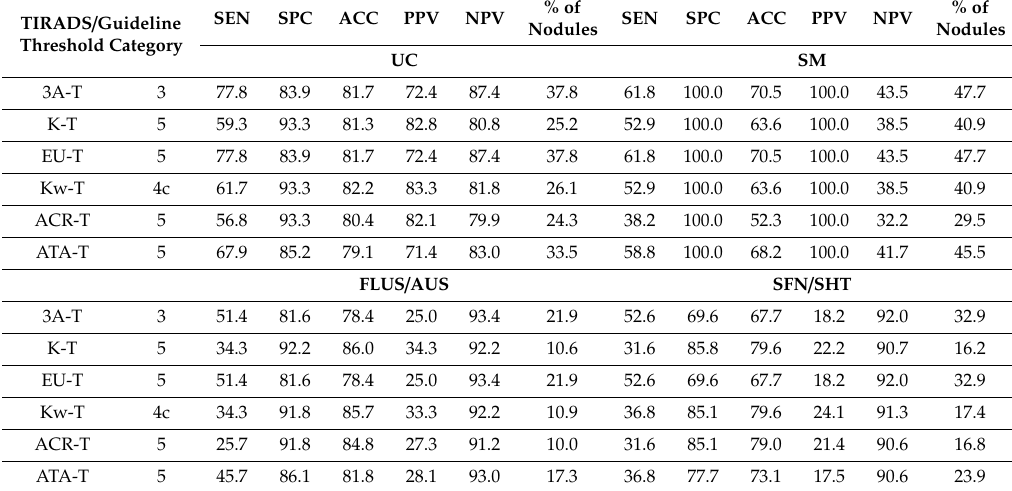
Table 4. Data on the diagnostic e ffi cacy of analyzed TIRADSs in examined groups of nodules—data for the thresholds that gave the highest ACC